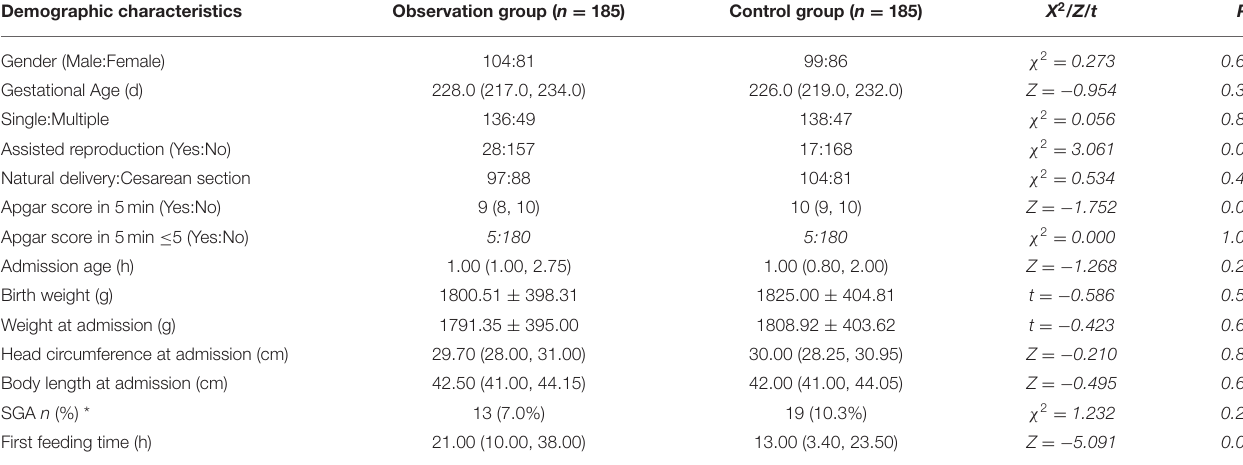
TABLE 1 | Characteristics of premature infants between the two